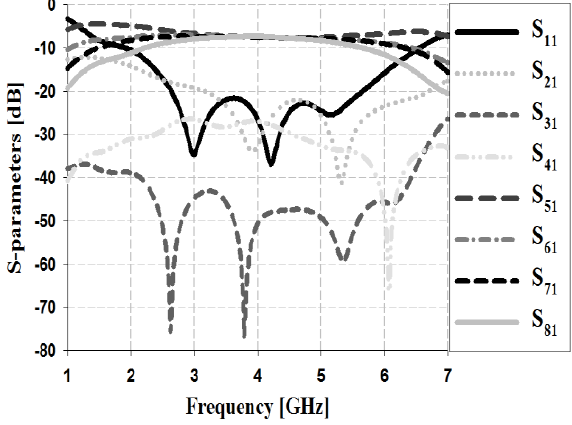
Figure 9. Phase and phase difference simulation analysis of the proposed shifter.